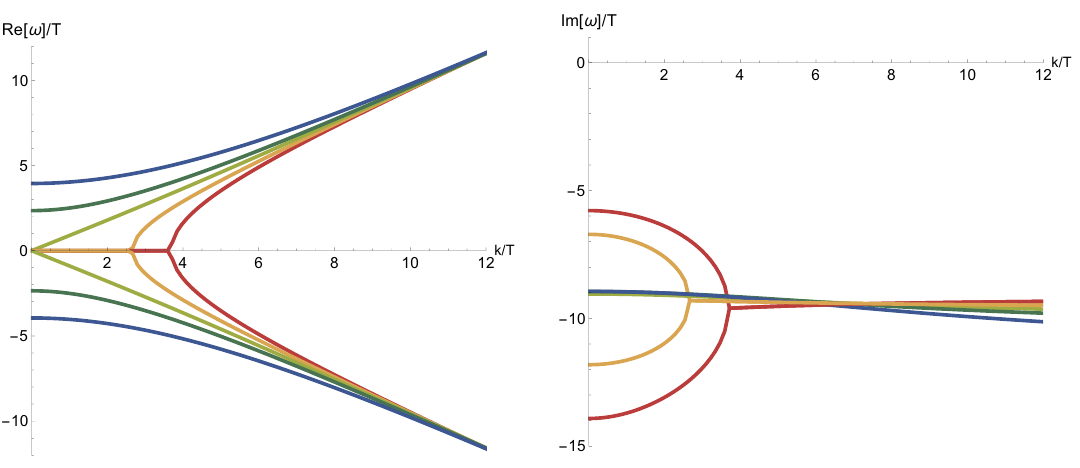
Figure 5 . The real ( left ) and imaginary ( right ) parts of the frequencies of the two lowest QNMs at (cid:12) = 0 for T=m 2 [0 : 14 ; 0 : 16] (blue-red).